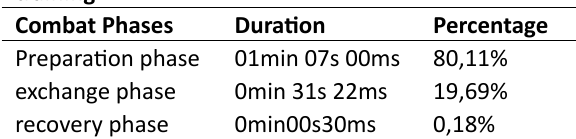
Table 5. Evaluation of the combat phases in training training Combat Phases